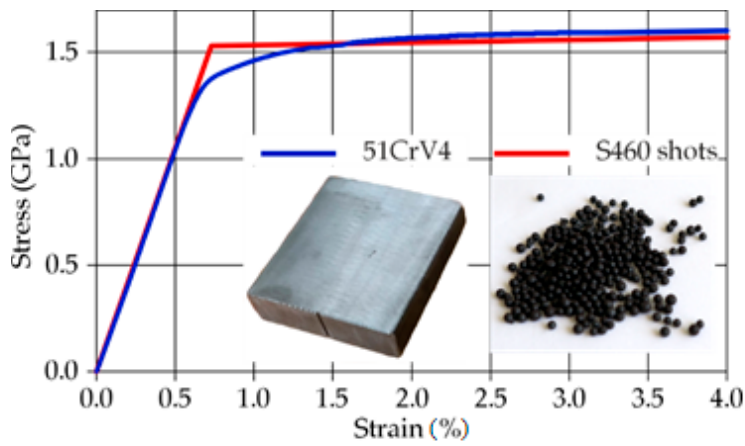
Figure 3. Stress–strain curves for the specimen (blue colored) and the shots (red colored).